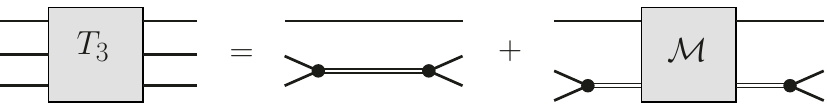
Figure 4 . Expressing three-particle amplitude in terms of a particle-dimer amplitude. Summing up over all possible choices of spectator particles is